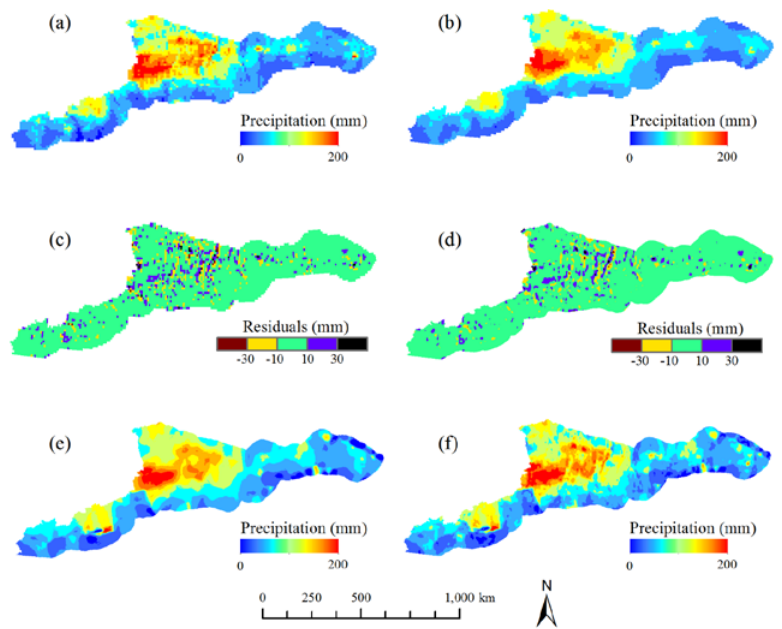
Figure 13. Comparison of the DS_CIMERG product in July 2016 before and after residual correction. ( a ) CIMERG; ( b ) predicted precipitation (10 km); ( c ) residuals (10 km); ( d ) residuals (1 km); ( e ) DS_CIMERG; ( f ) downscaled precipitation after residual correction.